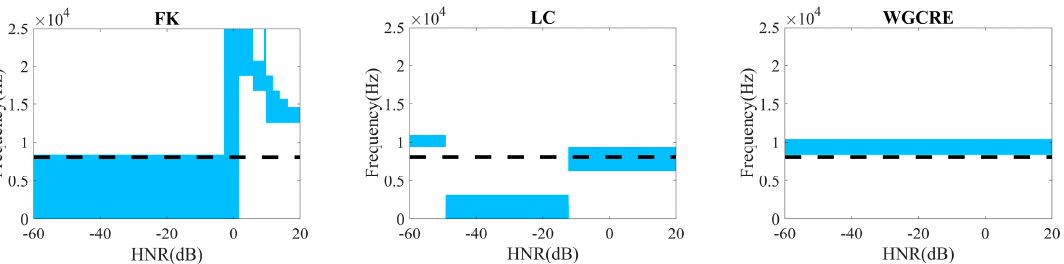
Figure 6. Selected optimal demodulation bands under single impulse for different HNR.